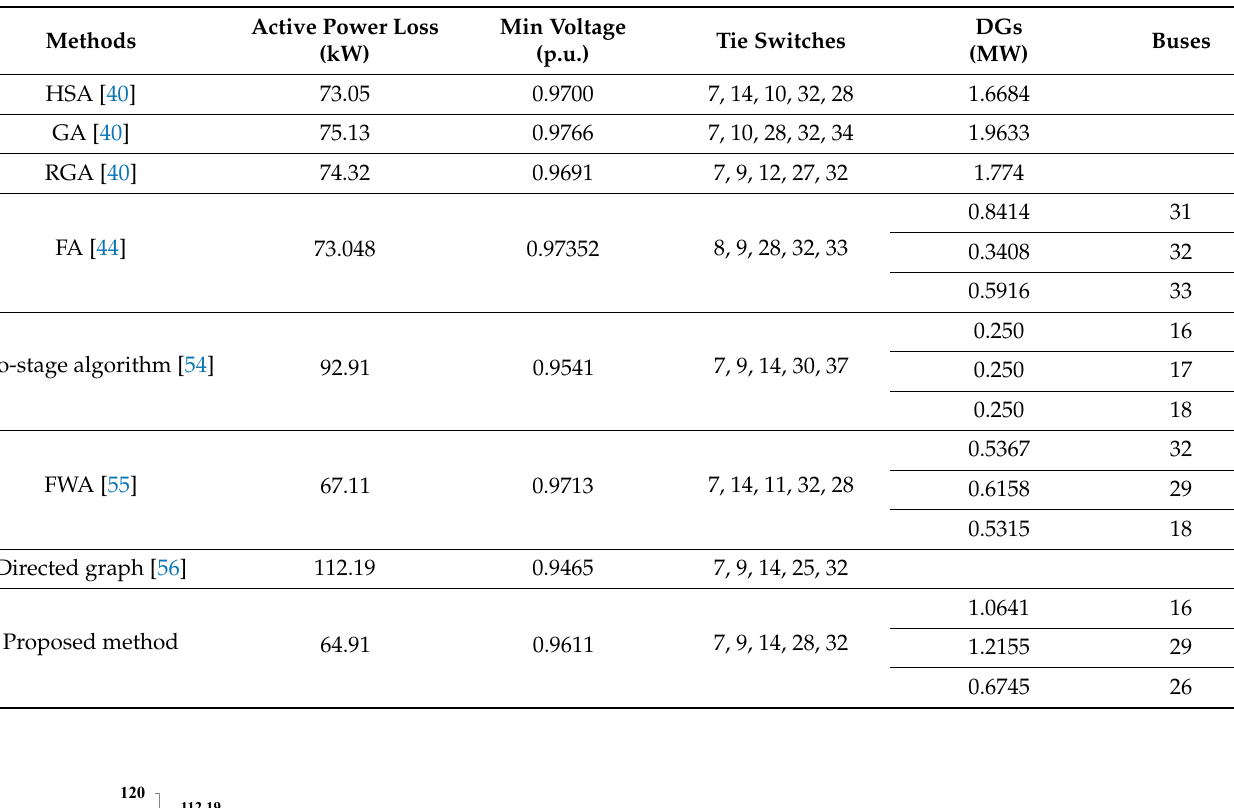
Table 3. Comparative results for the configured IEEE-33 bus distribution system with DG units.